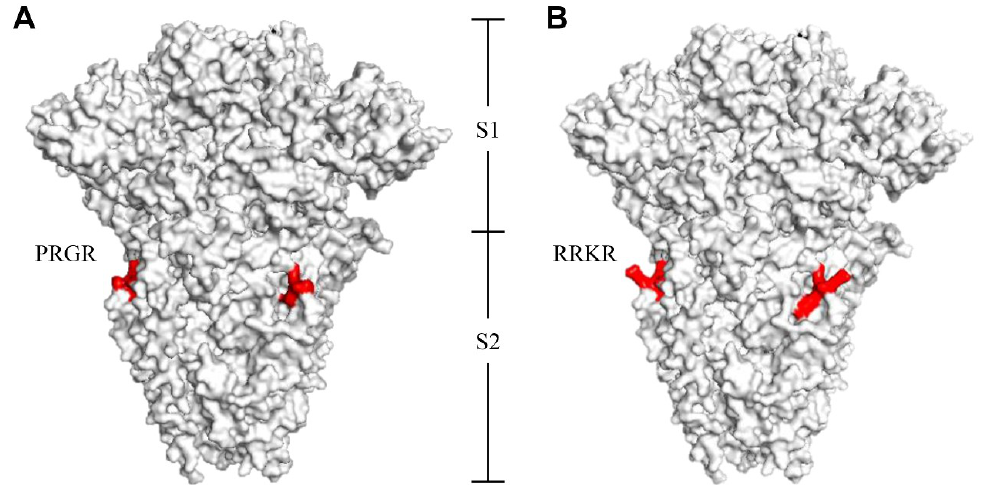
Figure 6. Structure of the S protein was predicted. We used homologous modeling to predict the structure of original and mutant S proteins according to the Cryo-EM structure of IBV S protein.